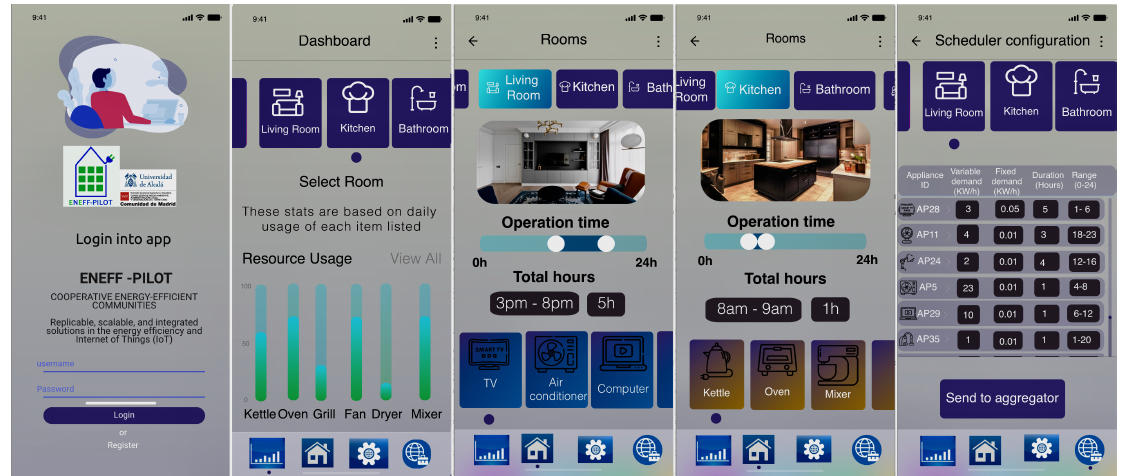
Figure 3. Consumer scheduling app.